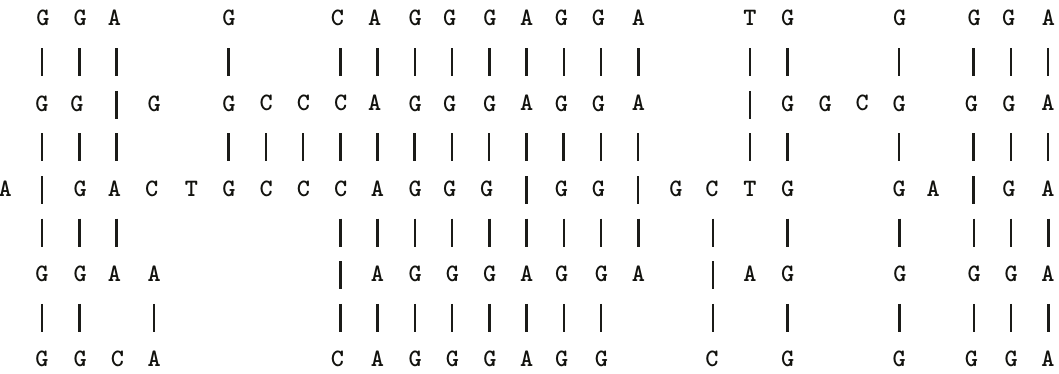
Figure 3: A “good” multiple sequence alignment amongst five DNA sequences. Reproduced with permission from Figure 3.1 in [1].